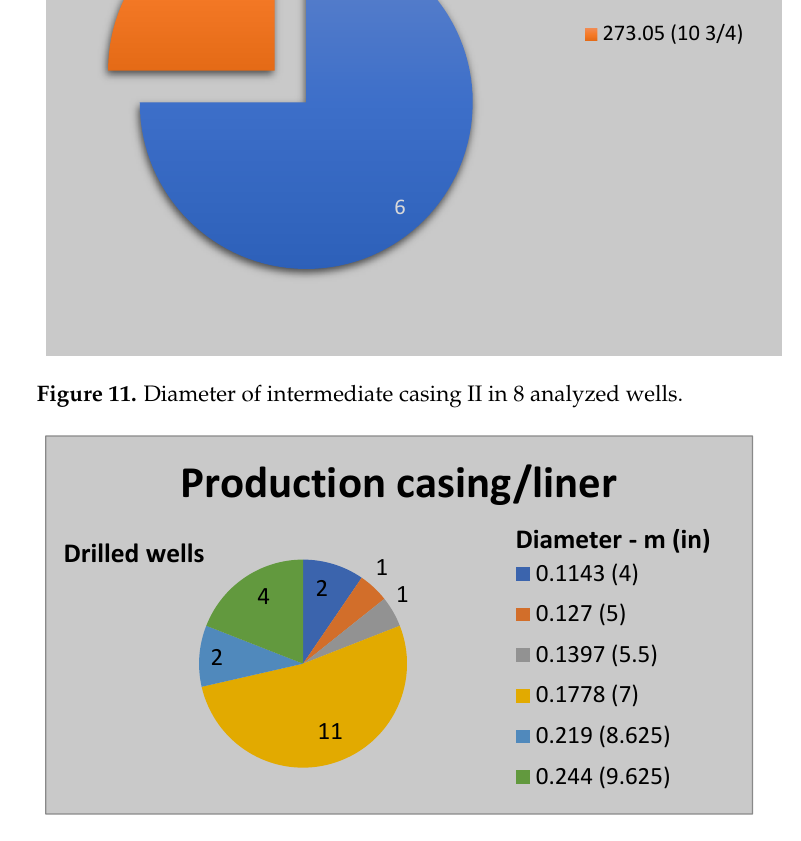
Figure 12. Diameter of production casing/production liner in 21 analyzed wells.